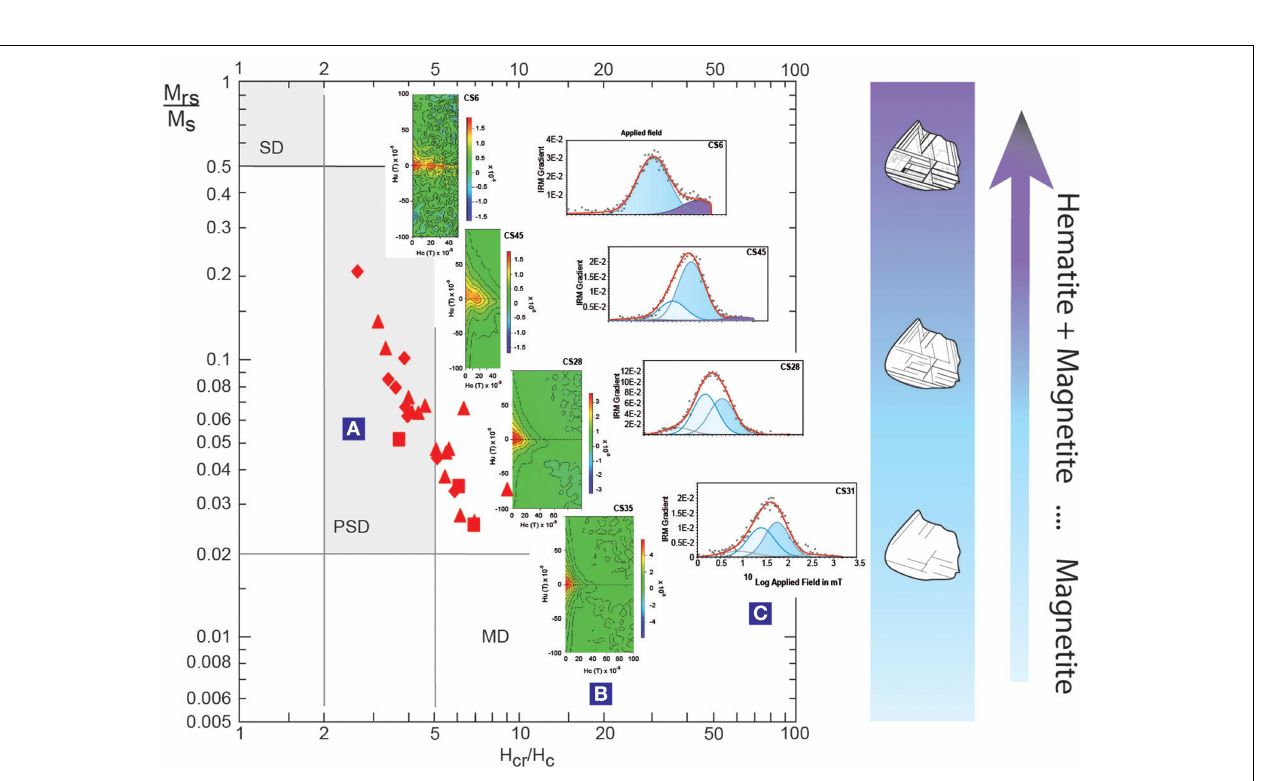
FIGURE 5 | Magnetic properties of the Biotite granite of Socotra. (A) Linear trend and PSD behavior on a Day-plot of Biotite granite samples. The diamonds, squares, and triangles, respectively correspond to the localization in Haggier Mont, Qalansya, and Sherebrub zones (see Figure 3 ) (B) IRM acquisition curves (linear and Gaussian cumulative treatment, respectively, showing magnetite dominance and hematite appearance with decreasing magnetic grain size. (C) FORC diagrams showing SD and PSD behavior disappearance to a MD-like behavior and increasing magnetic interactions with increasing magnetic grain